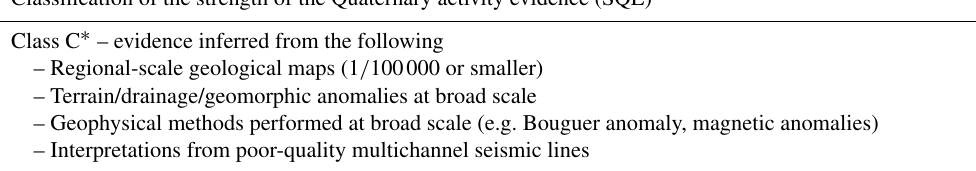
Table 1. Classification of the strength of the Quaternary activity evidence (SQE) of a fault in three levels of increasing significance, based on the scale of the available observations, type of data and methods used. The classification is not intended to be exhaustive but to furnish the approach and criteria used in QAFI v.3. See text for further information.